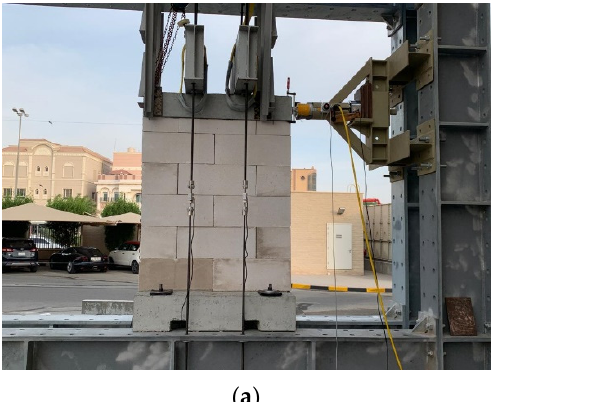
Figure 13. Walls prior to testing. ( a ) Unreinforced wall and ( b ) reinforced wall.